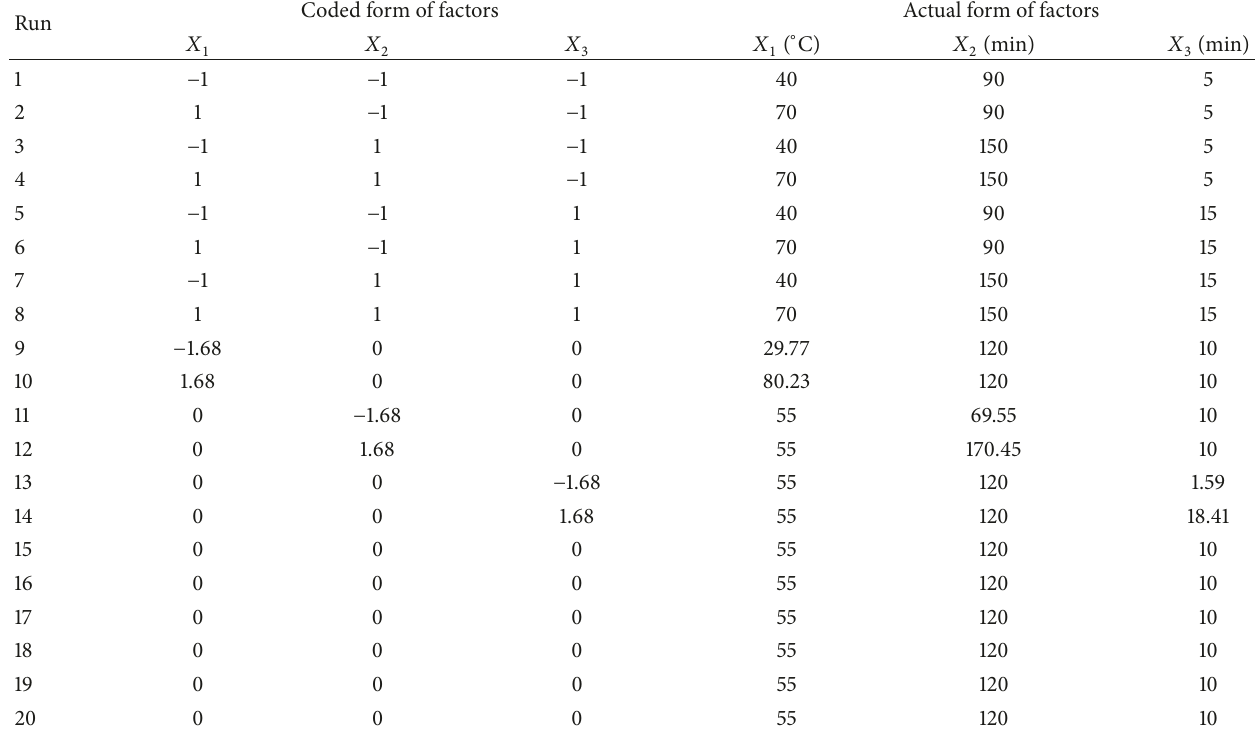
Table 1: Design of CCD for independent variables.